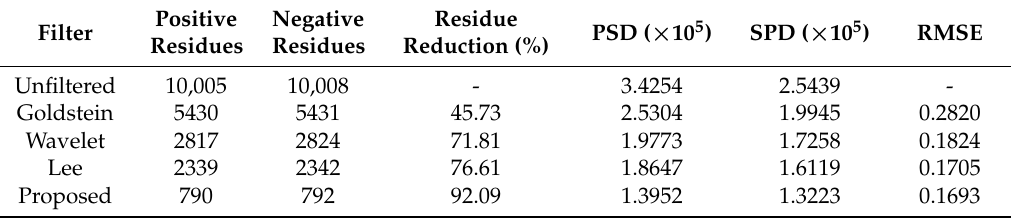
Table 2. Quantitative evaluation with the real data over Etna volcano, PSD: the phase standard deviation; SPD: the sum of phase difference, RMSE: the root mean square error .